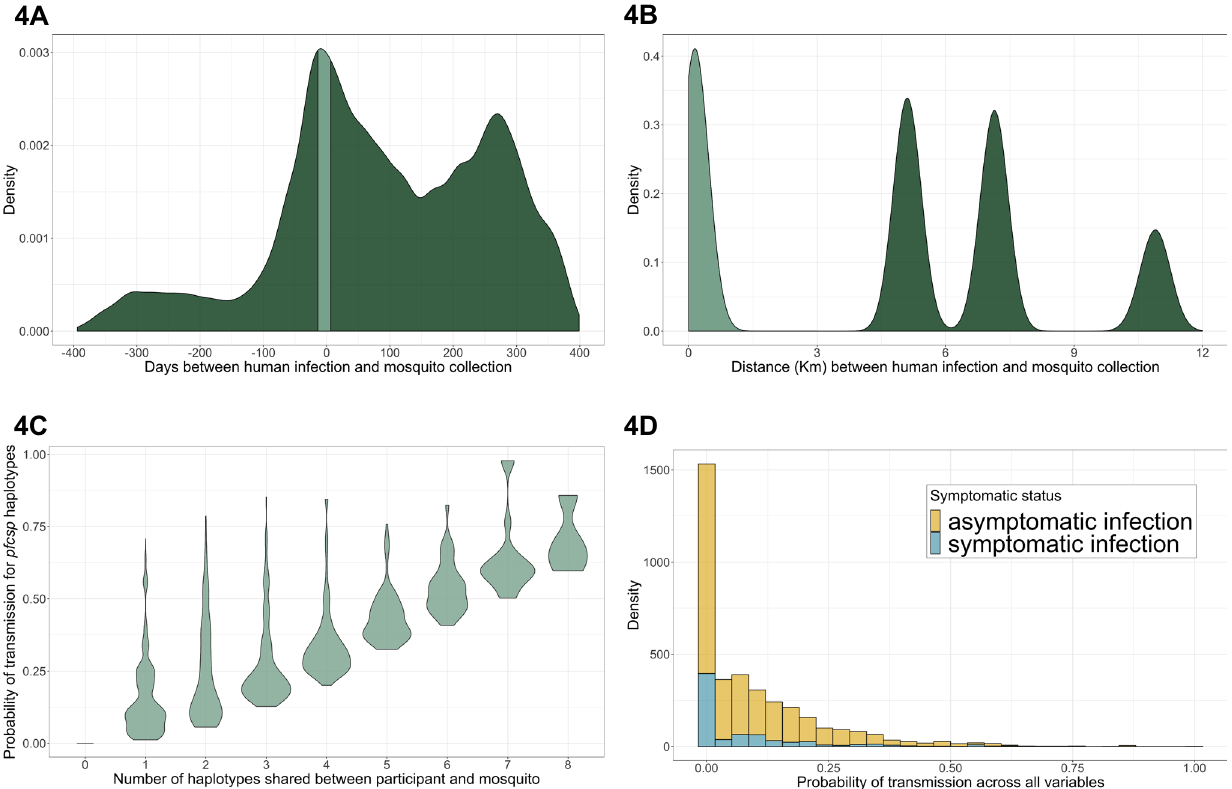
Fig. 4 Modeling approach to estimate the probability of a P. falciparum transmission event to mosquitoes using the pfcsp gene target. A Distribution of the interval in days between all possible pairings ( N = 159,285) of all infected participants and mosquito abdomens. Day 0 was set as the date of the mosquito infection, and therefore negative values indicate that the mosquito was collected prior to the participant infection. The light green area indicates those pairings in which the mosquito was collected within 7 days prior to or 14 days after the participant ’ s infection. Subsequent analysis was restricted to these pairings. B Distribution of the distance interval between all possible pairings of infected participants and mosquito abdomens. The light green area indicates those pairings within the same village and at a maximum distance of 3 km, to which subsequent analysis was restricted. Across these pairings, a probability function was applied (Fig. S7) to upweight pairings with shorter distance intervals. The peaks result from differences in distance across the three villages. C Distribution of the estimated probabilities of transmission as a function of the number of pfcsp haplotypes shared within the participant – mosquito pair. These probabilities were estimated by upweighting pairings which shared more haplotypes and which shared haplotypes that were rare across the entire study population. D Distributions of the fi nal estimated probabilities of transmission events strati fi ed by symptomatic status of the participant infection. Final probabilities were computed as the product of the individual probabilities based on the time interval, distance interval, and pfcsp haplotypes of each